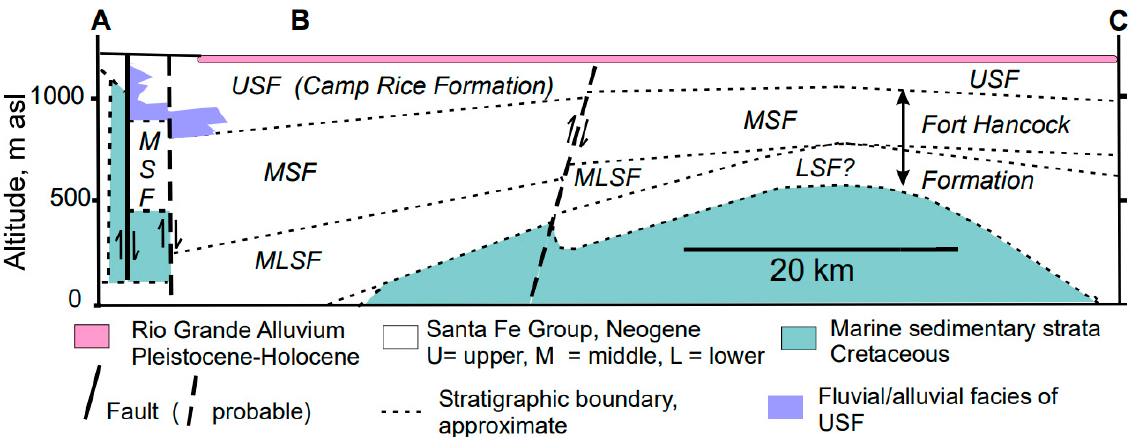
Figure 1. ( a ) Regional location map with an inset showing the location of the figure in North Amer- ica. ( b ) Map of the southern part of the Hueco Bolsón. Grounwater collection areas are shown thus: CB = central basin; MF = mountain front; VJ = Valle de Juárez; EHB = east Hueco Bolsón. River locations shown with km from the source. EP = El Paso, CJ = Ciudad Juárez, IHS = Indian Hot Springs, ABC = cross-section in Figure 2.